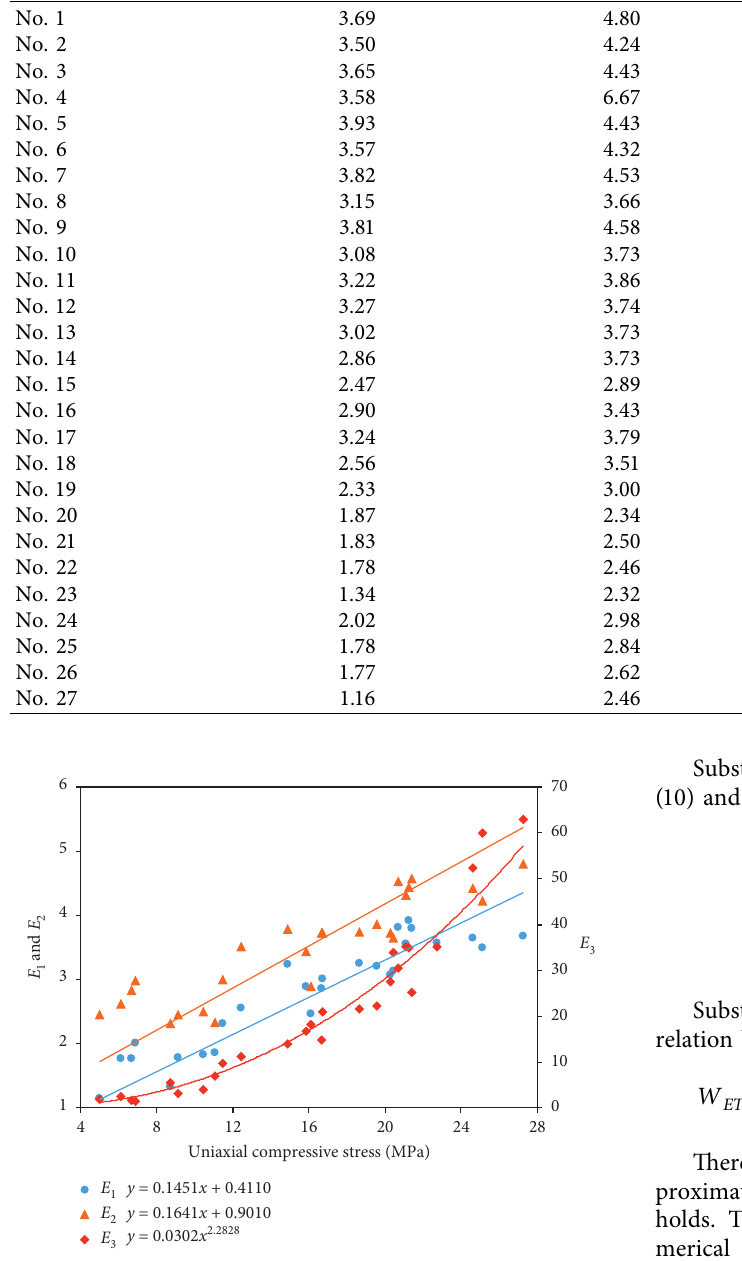
Figure 6: The variation of E